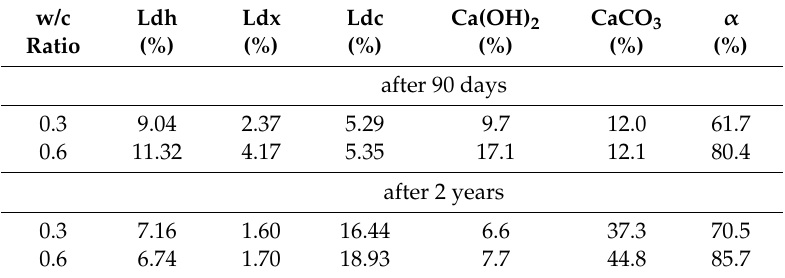
Figure 9. TG/DTA analyses of pastes with w/c ratios of 0.3 and 0.6 after 90 days and 2 years of curing. Table 3. Results of the tests conducted.